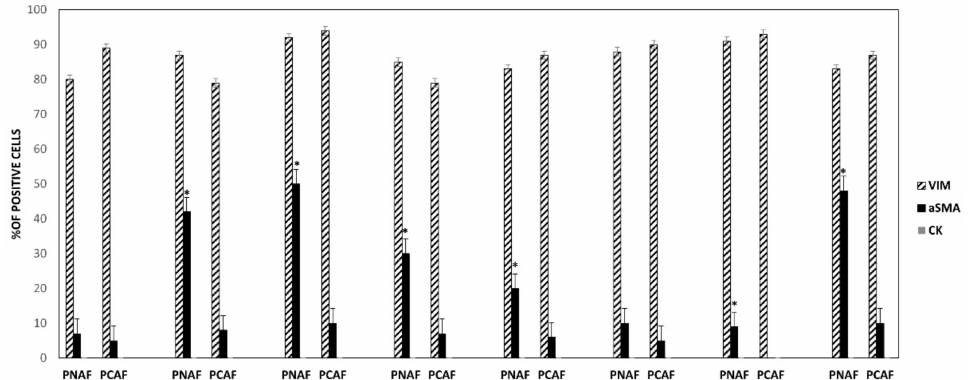
Figure 1. Characterization of patient-derived fibroblast cells. Quantification of the percentage of Vimentin (VIM), cytokeratin 18 (CK), and α SMA positive cells per total number of cells in a given field after immunofluorescence staining of matched paired prostate-cancer-associated fibroblasts (PCAFs) and non-cancer-associated fibroblasts (PNAFs) cell cultures obtained from radical prostatectomy in different patients. * p ≤